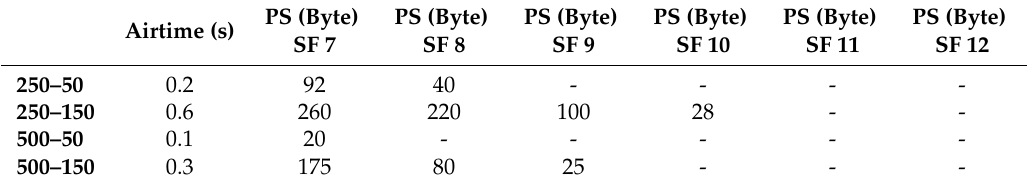
Table 4. Payload sizes (PS) of IoB-LR with different